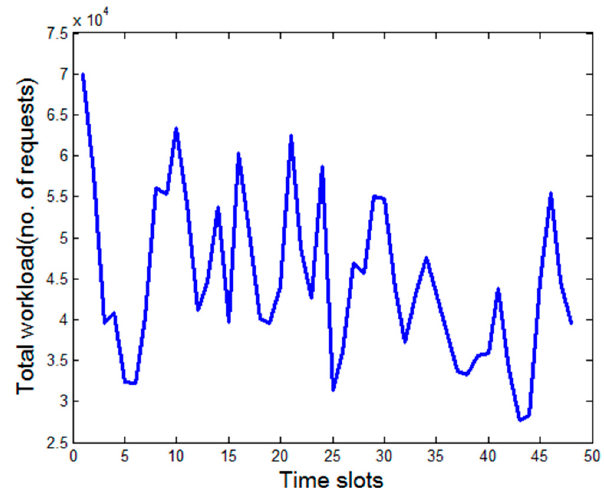
Figure 5. Total workload generated by all the Software-as-a-Service (SaaS) providers together. This is